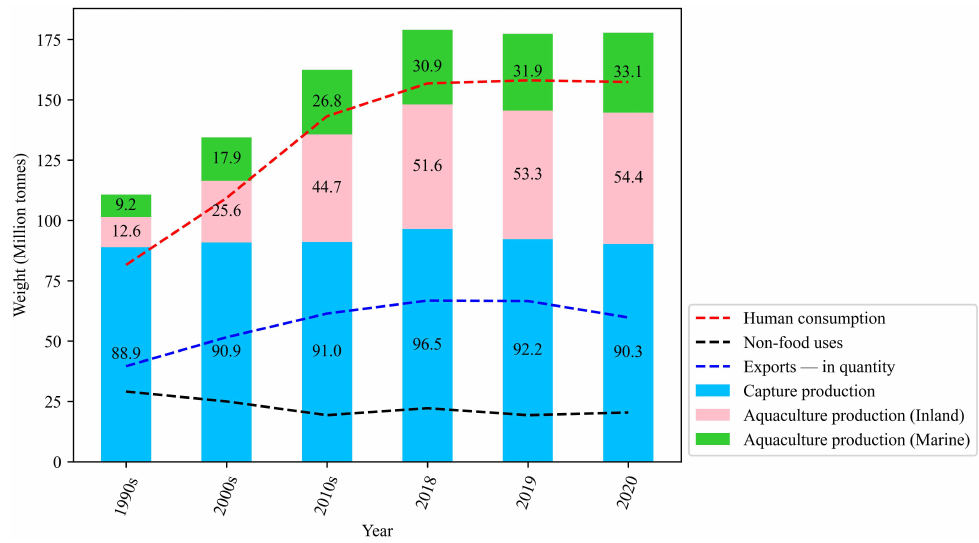
Figure 1. World aquaculture and fishery production and consumption. Data source: